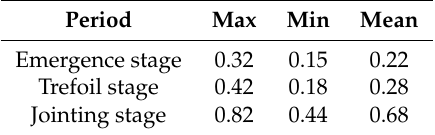
Table 3. The Max, Min, and Mean values of NDVI